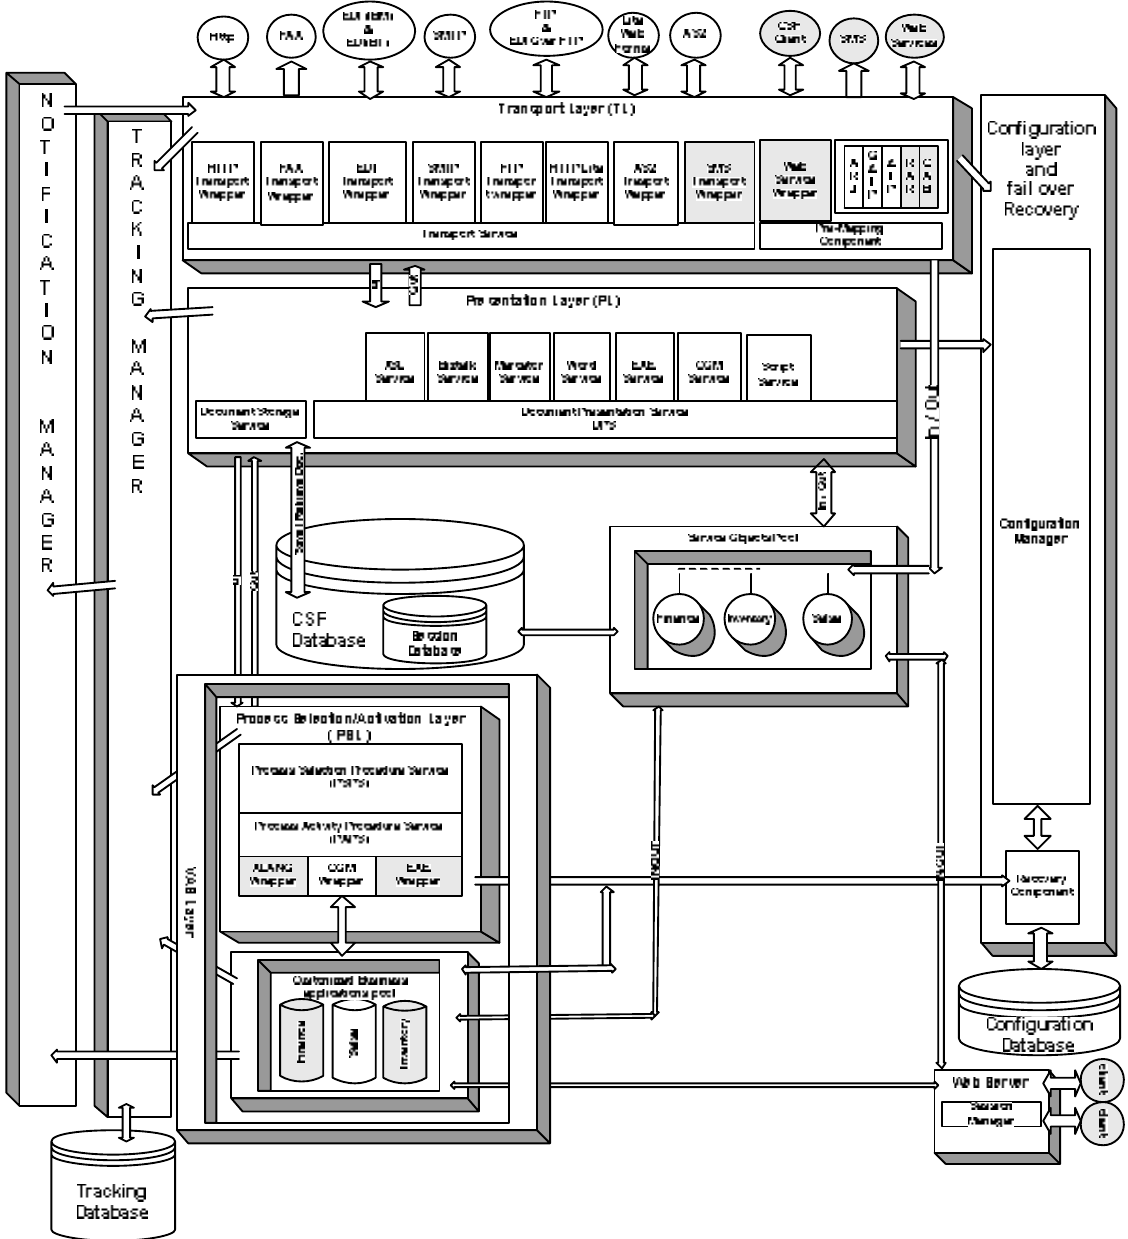
Figure 6: Collaborative Solution Framework Architecture